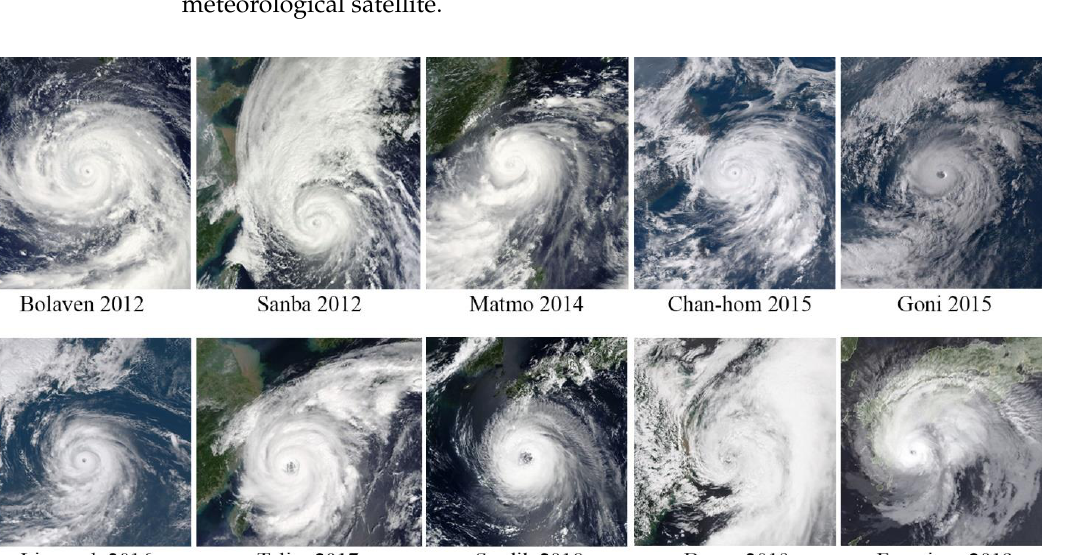
Figure 3. Typhoon Lionrock trajectory aligned with the images made by the “Himawari - 8” satellite in the visible range. In the scheme in Figure 1, the trajectory of the typhoon is indicated in green. Accord- ing to the scheme, the tropical cyclone entered the Sea of Japan on 30 August 2016, lived over it for a short time and, upon entering the Primorsky Territory, filled up quickly. Fig- ure 4 shows dynamic spectrograms of synchronous records of the laser strainmeter in the ranges of the “ voice of the sea ” (6 – 11 Hz) and wind sea waves (2 – 20 s). It is important to note that in the data of the laser measurer of hydrosphere pressure variations [18], we do